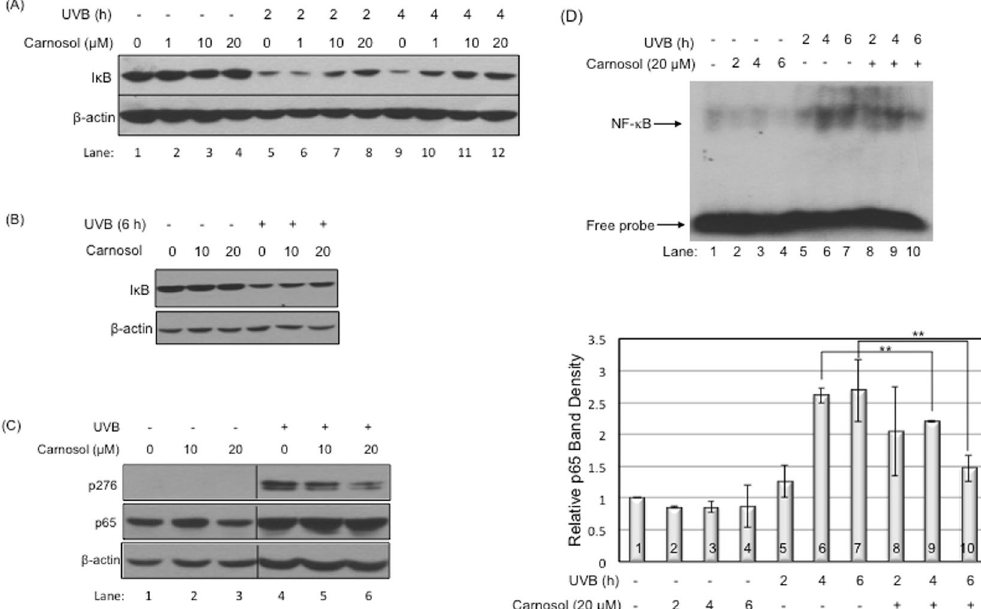
Figure 7. Carnosol inhibited UVB-induced NF- κ B activation. Cells were exposed to UVB radiation (50 mJ/cm 2 ) in the presence or absence of carnosol. Cells were lysed at indicated time point and protein levels were determined by western blot analysis. ( A ) Western blot for I κ B protein level in HaCaT cells at 0, 2, 4 hours post UVB radiation at 1, 10 or 20 μ M carnosol treatment. ( B ) Western blot analysis for I κ B protein level in HaCaT cells at 6 hours post UVB radiation in the presence or absence of carnosol (10 or 20 μ M). ( C ) Western blot for S276 site phosphorylation of NF- κ B in HaCaT cells at 6 hours post UVB radiation with 10 or 20 μ M carnosol treatment. See supplement material for full-length western blot figure. ( D ) EMSA assay and its statistical analysis for HaCaT cells at 0, 2, 4, 6 hours post UVB radiation in the presence or absence of carnosol (20 μ M). ** p <